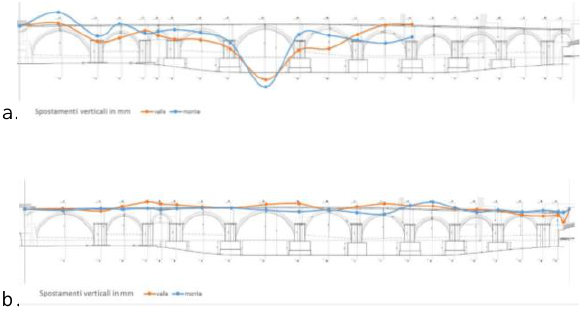
Figure 3. vertical displacements during load testing: during type B test (a), during the unload epoch (b).